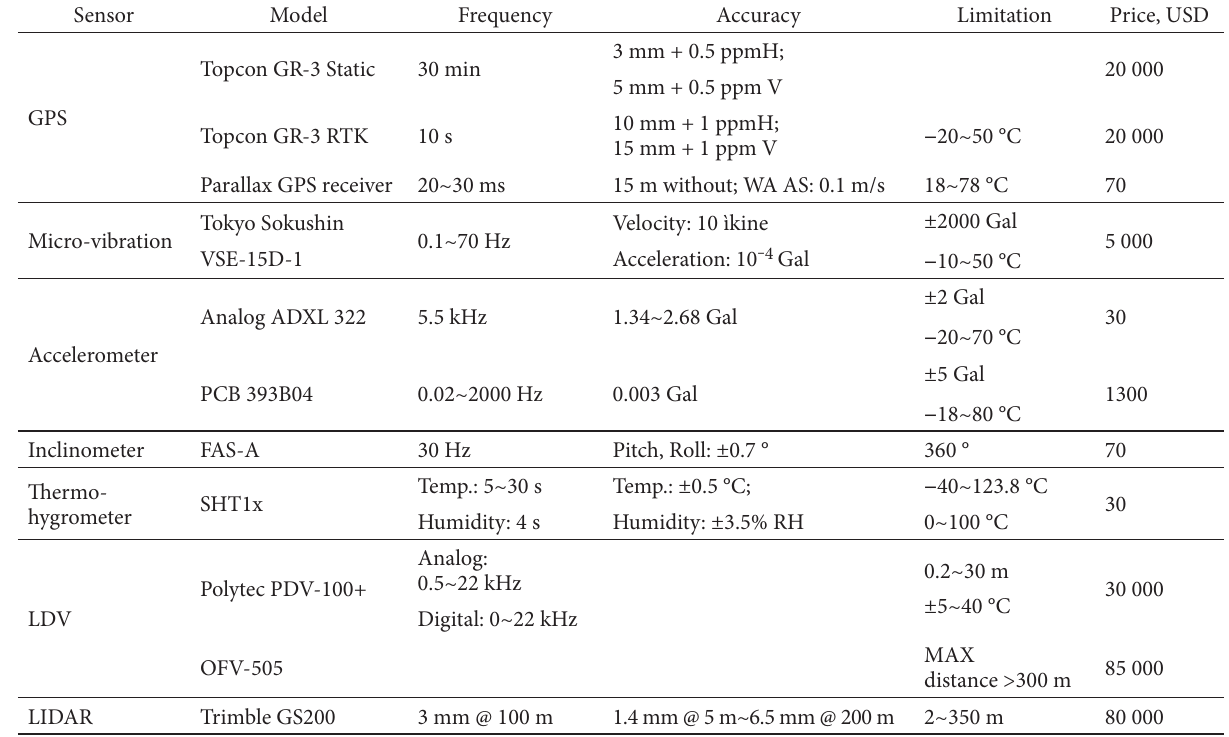
Table 1. Table of different sensors Sensor